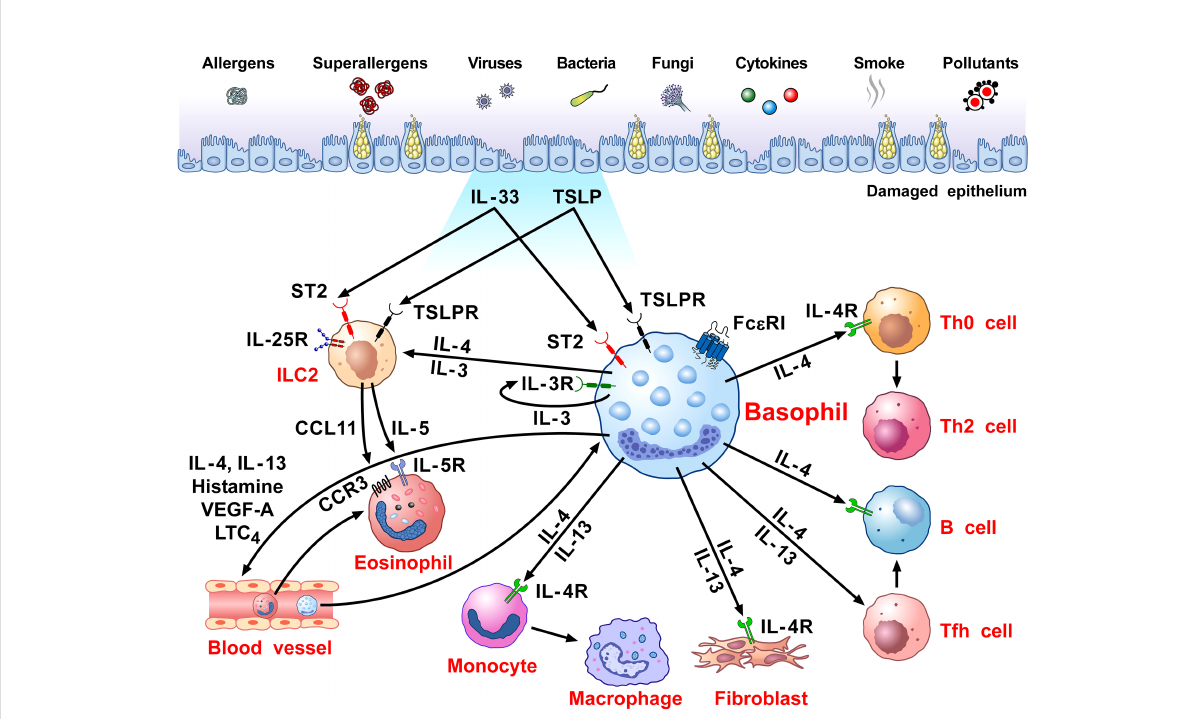
FIGURE 1 Schematic representation of the versatile role of basophils in the pathobiology of allergic disorders. Several immunological (i.e., allergens, superallergens, viral, bacterial and fungal proteins, cytokines) and non-immunological stimuli (e.g., pollutants, diesel exhaust particles) activate mucosal (i.e., lung and gut) and skin barriers to release different alarmins (i.e., TSLP, IL-33, IL-25) (130, 216, 217). Alarmins activate group 2 innate lymphoid cells (ILC2s) through the engagement of speci fi c receptors (TSLPR, ST2, IL-25R, respectively) (218, 219) to release IL-5 and CCL11 that promote eosinophil in fi ltration into in fl amed tissue (220, 221). Human and mouse basophils express the high-af fi nity receptor for IgE (Fc e RI) (36, 37) and the receptors for IL-3 (IL-3R a /CD123) (34, 44), GM-CSF (CD116) (45, 46), IL-33 (ST2/IL1RL1) (47 – 50), IL-5 (CD125) (51) and a variety of chemokine receptors (5, 55 – 60). The TSLP receptor (TSLPR/IL-7R a ) is expressed by mouse basophils (12, 34), but its presence on basophils from allergic and healthy donors remains controversial (12, 14 – 16). TSLP activates mouse but not human basophils (12, 17). IL-3 plays a key